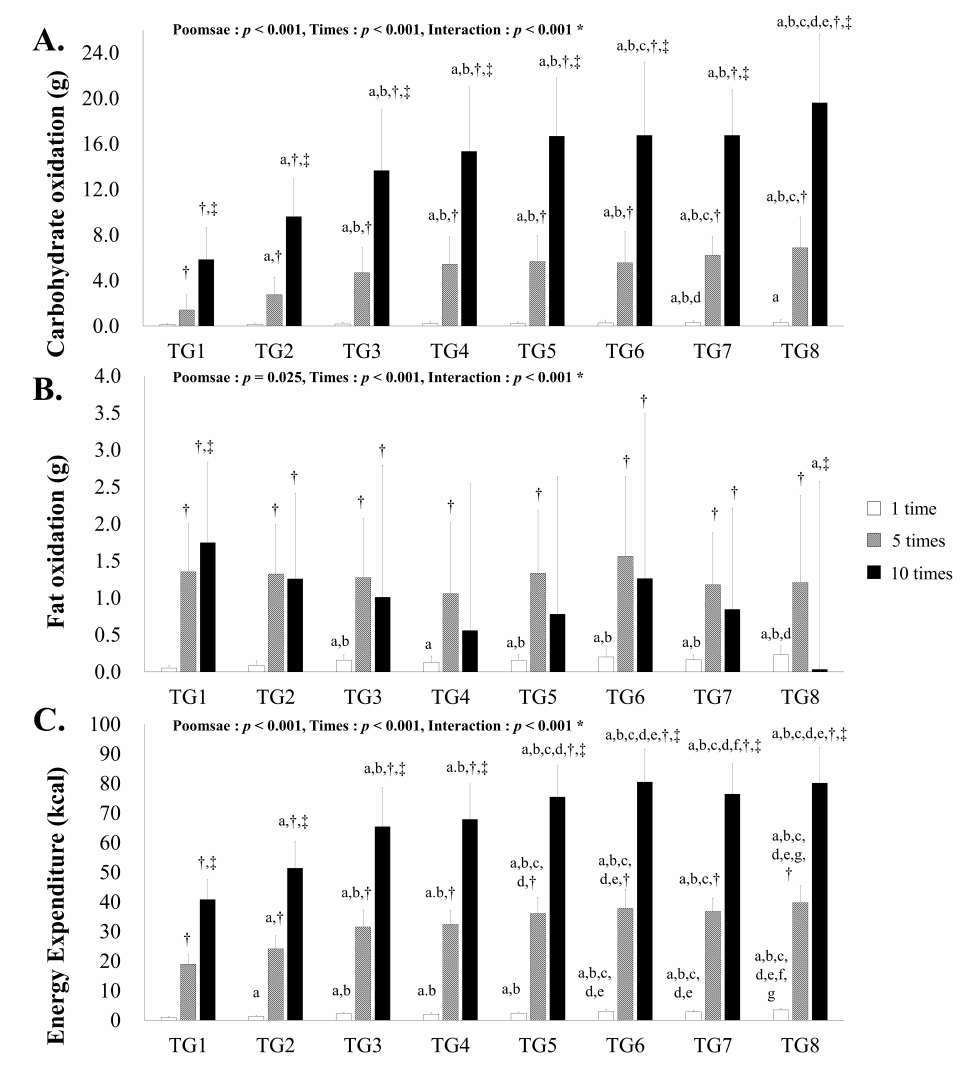
Fig. 4. Energy metabolism of Taekwondo Taegeuk Poomsae (mean ± standard deviation). (A) Change in CHO oxidation, (B) change in fat oxidation, (C) change in EE are shown. TG, Taegeuk; CHO, carbohydrate; EE, energy expenditure. a: p < 0.05 vs. TG1, b: p < 0.05 vs. TG2, c: p < 0.05 vs. TG3, d: p < 0.05 vs. TG4, e: p < 0.05 vs. TG5, f: p < 0.05 vs. TG6, g: p < 0.05 vs. TG7. †: p < 0.05 vs. 1st repetition, ‡: p < 0.05 vs. 5th